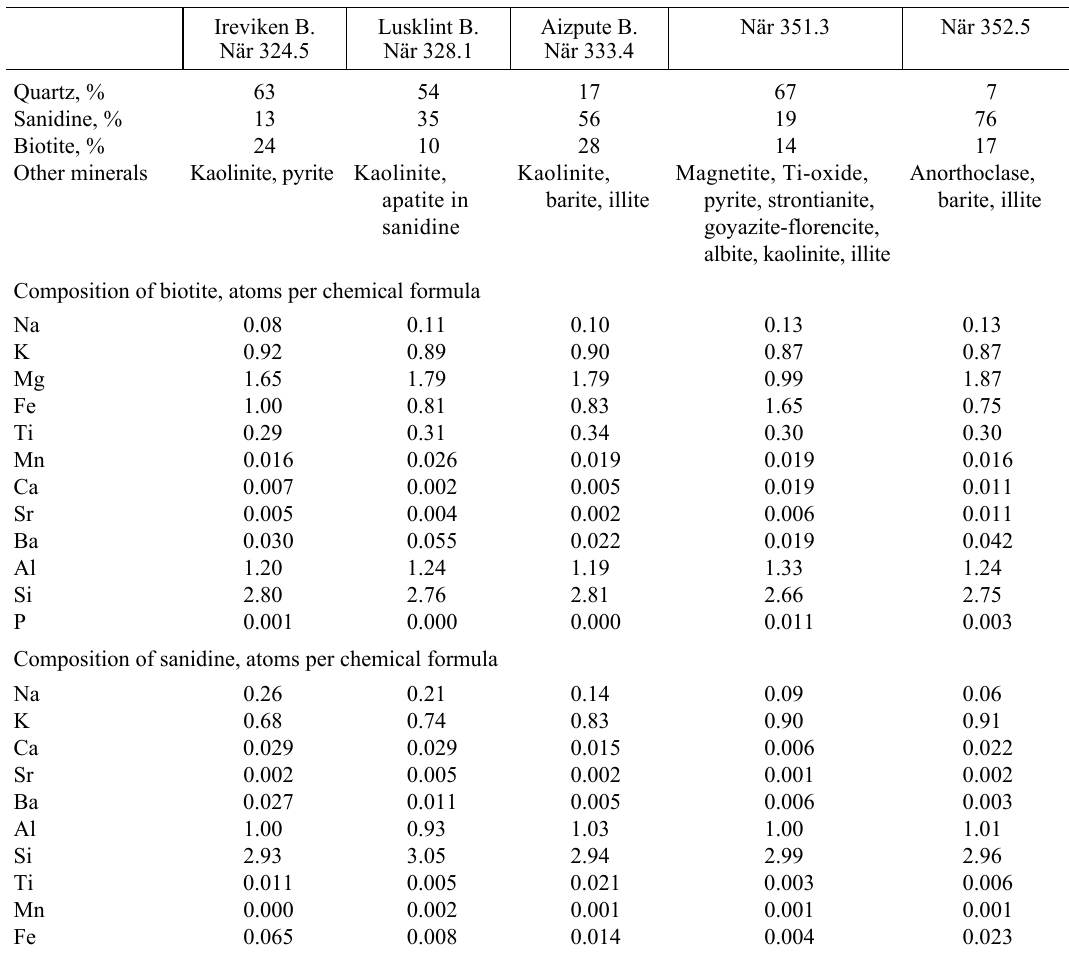
Table 2. Composition of phenocrysts in ash beds of the N(cid:228)r core Ireviken B. N(cid:228)r